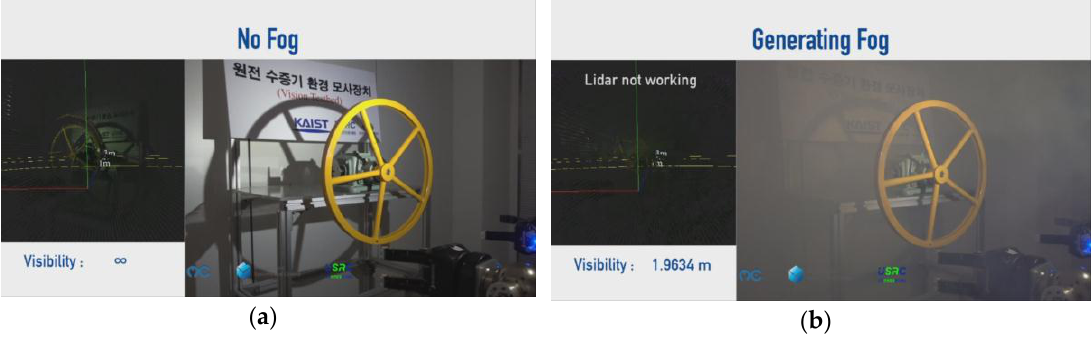
Figure 11. Visibility comparison: ( a ) without fog and ( b ) dense fog.